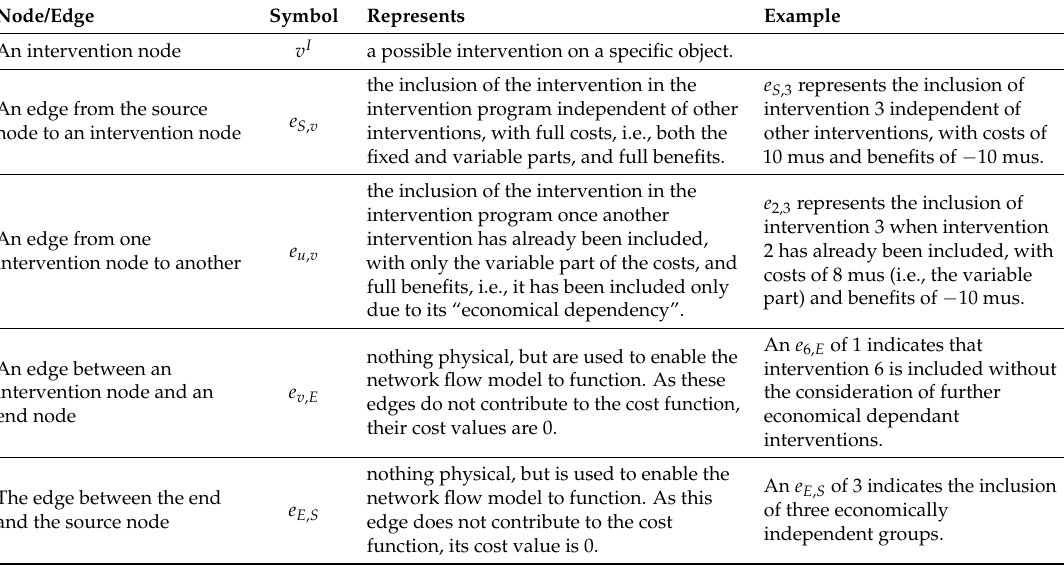
Figure 3. Economical, structural, and topological dependencies. Table 3. Meaning of components of the model in the intervention layer.